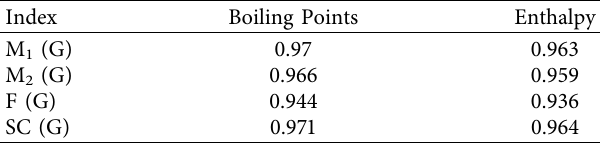
Table 2: The correlation coefficient for the Asthma